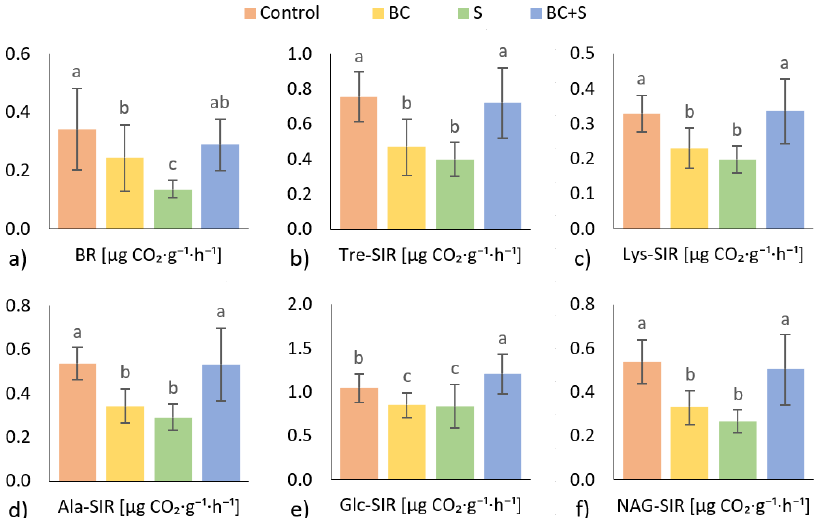
Figure 3. Basal respiration ( a ), trehalose SIR — Tre-SIR ( b ), L-lysine SIR — Lys-SIR ( c ), L-alanine SIR — Ala-SIR ( d ), D-glucose SIR — Glc-SIR ( e ) and N-acetyl- β -D-glucosamine SIR — NAG-SIR ( f ); tested treatments: BC — biochar, S — sulphur, BC + S — biochar and sulphur. Mean ± SD. The different letters